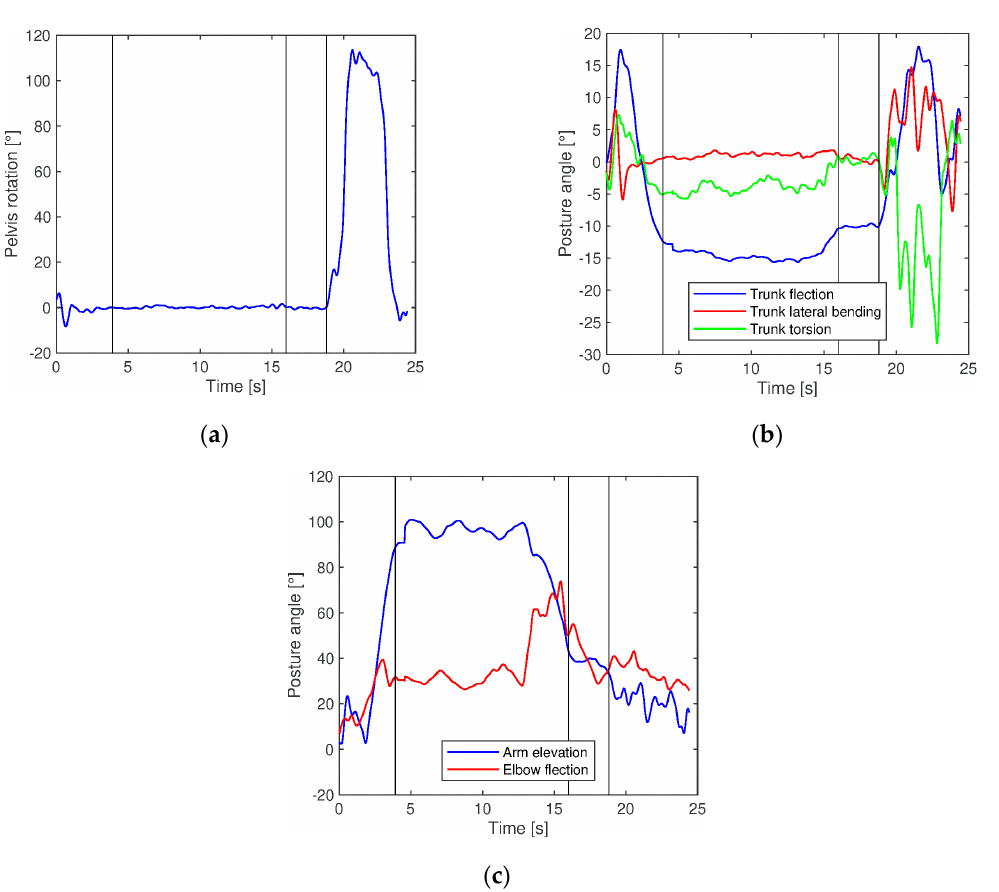
Figure 6. Posture angle trend for pelvis ( a ), trunk ( b ), and right limb ( c ) over one working cycle and triggers operations splitting.